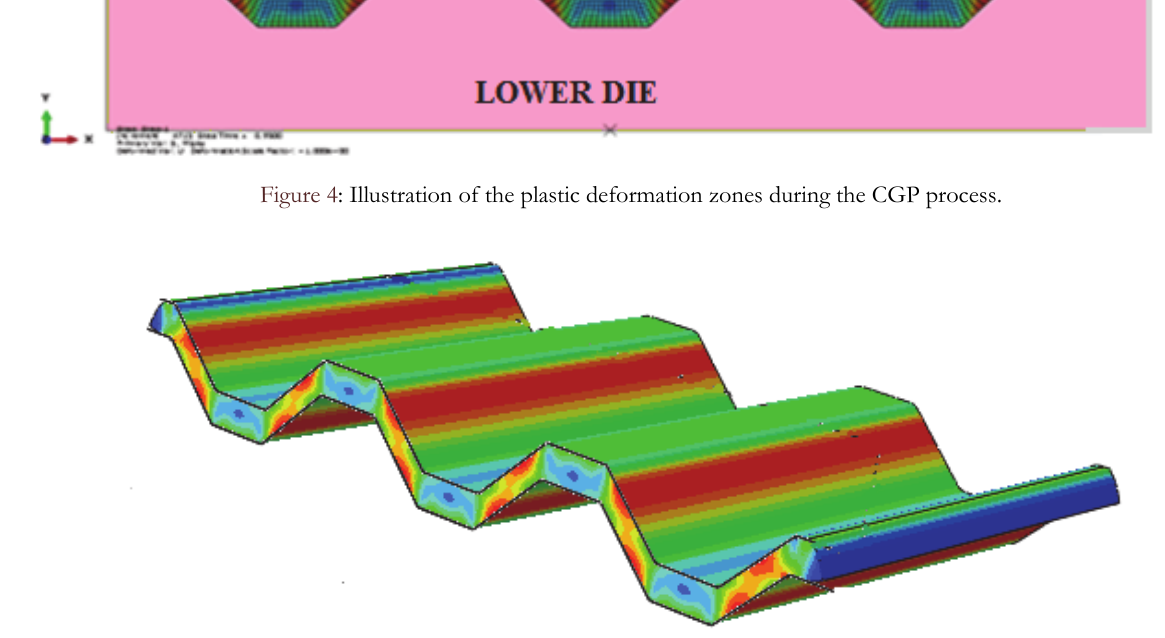
Figure 5: Sample after plastic deformation of the CGP process.